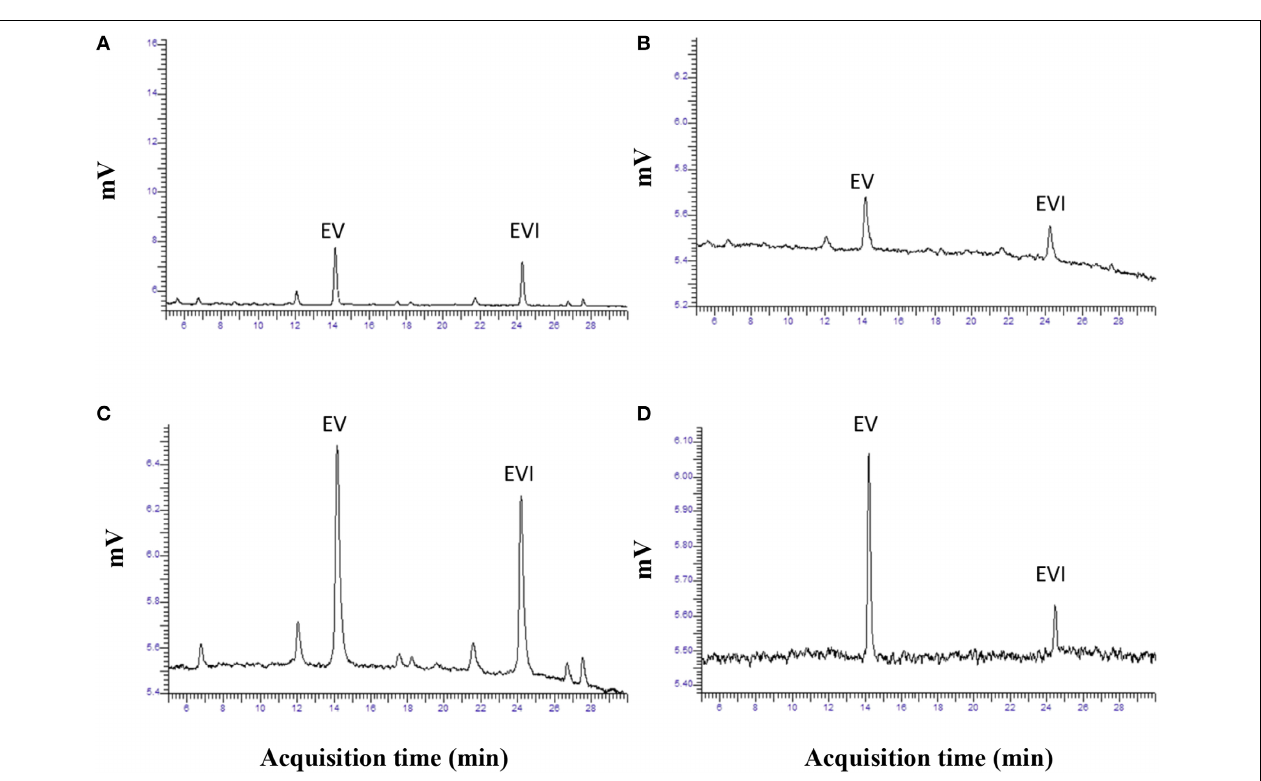
FIGURE 3 | Chromatograms of ergovaline from initial seed to a partially purified material. Panel (A) is chromatogram of routine analysis of powdered seed (EV, ergovaline; EVI, ergovalinine). Panel (B) is a chromatogram